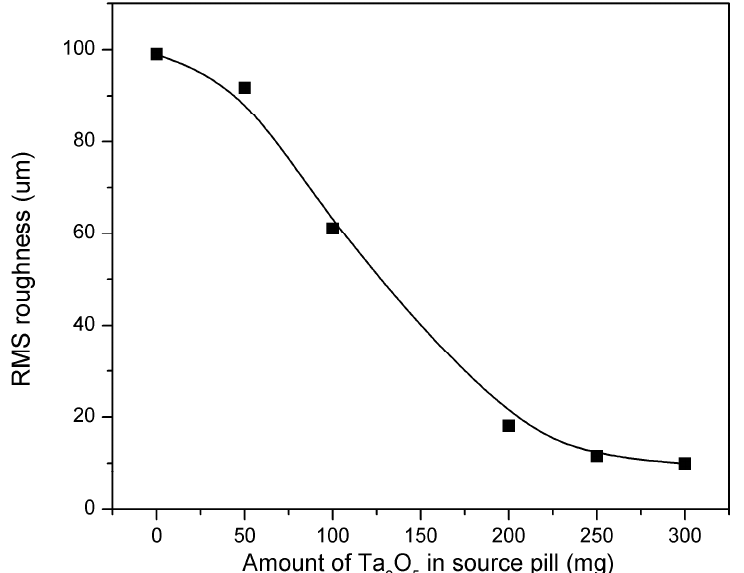
Figure 8. Roughness dependence in films obtained according to the amount of Ta in the source pellet.